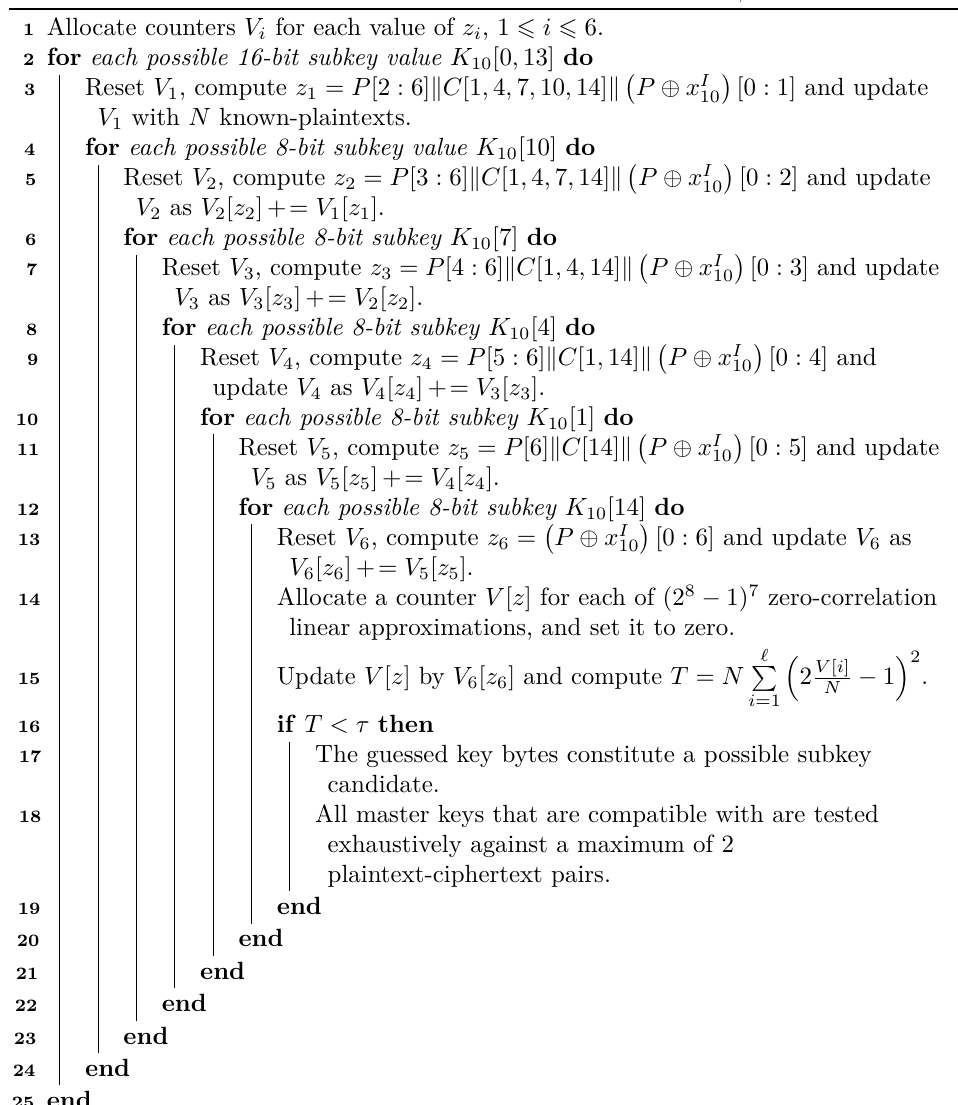
Algorithm 8: Zero-correlation linear attack on Dual-AES-PRF 9 ,